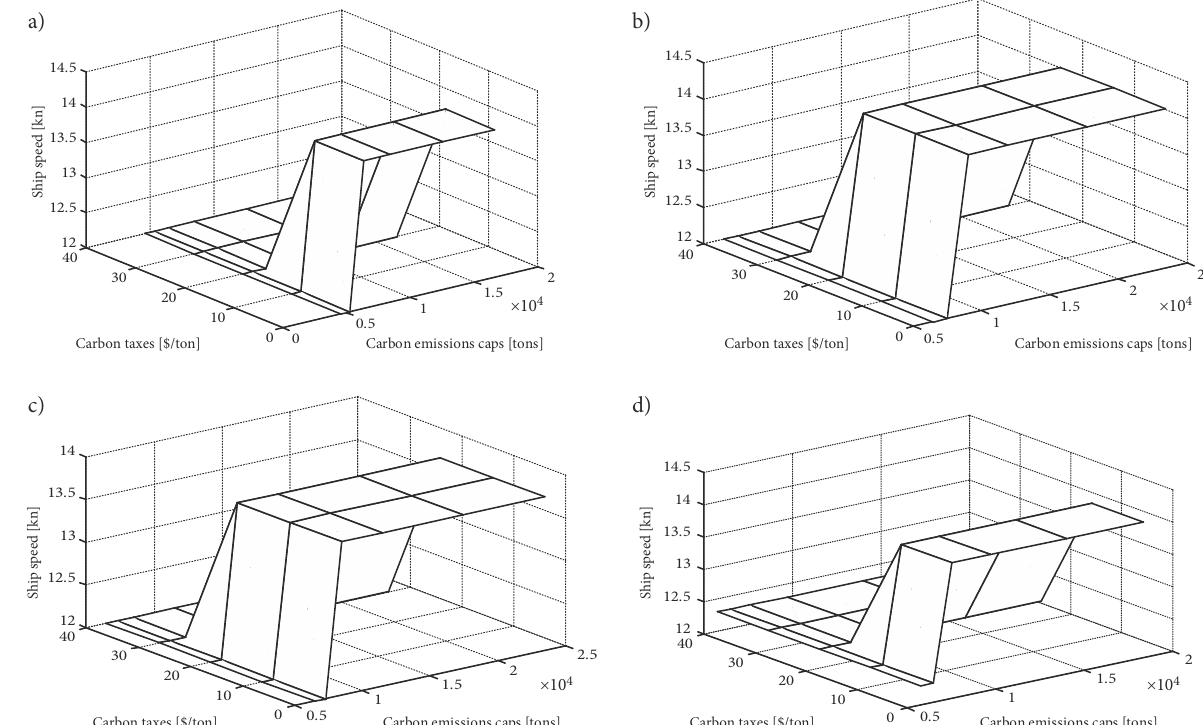
Figure 3. Changes in ship speeds under different carbon taxes and the carbon emissions caps